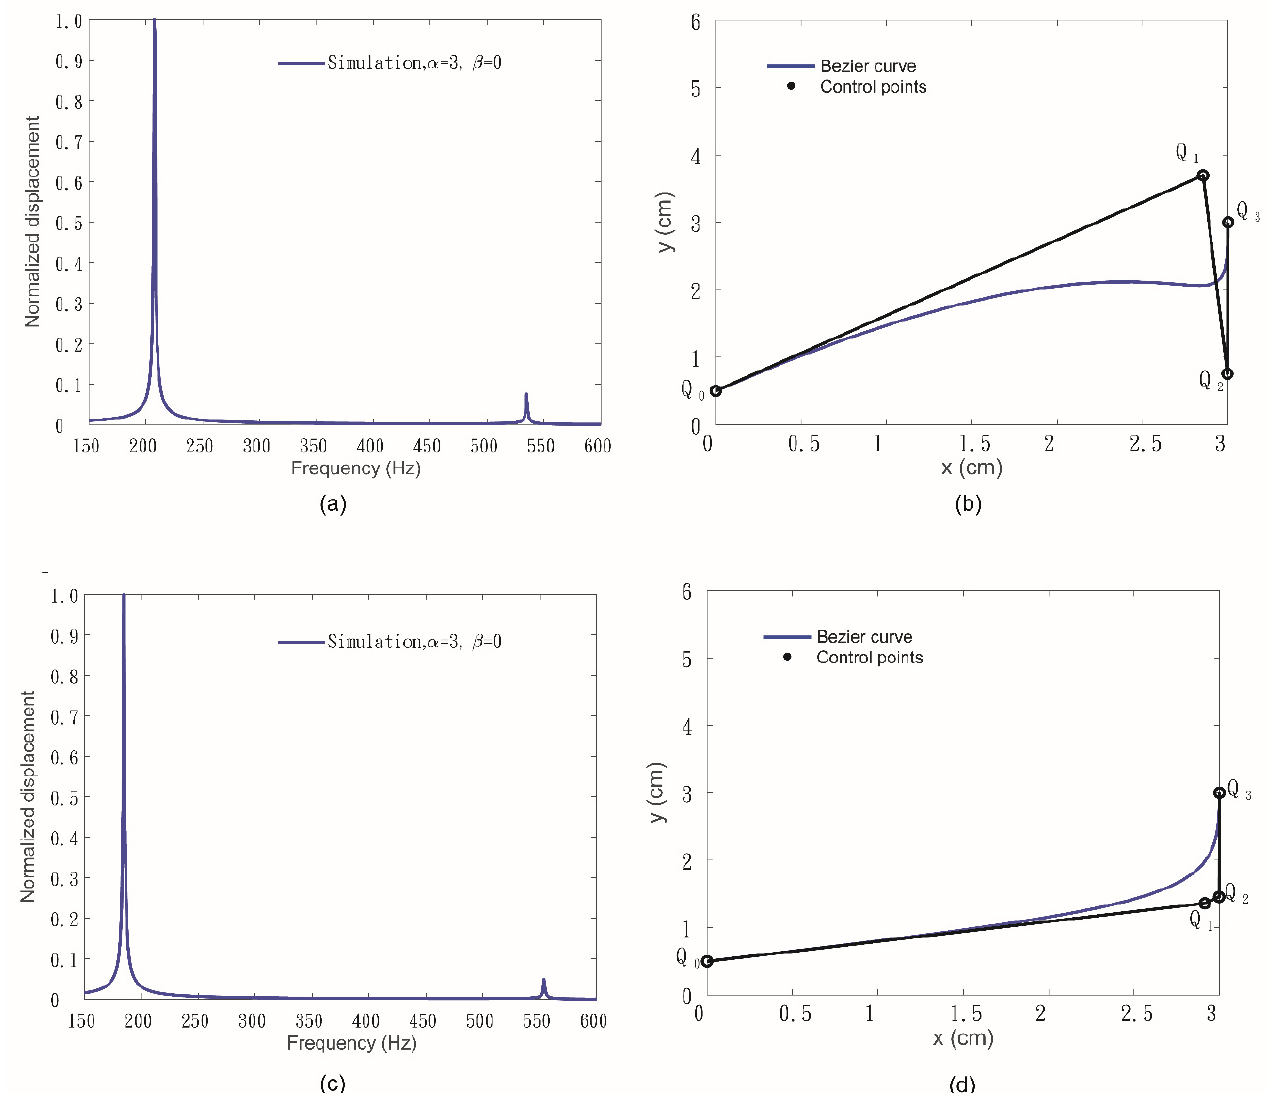
Figure 8. Normalized frequency response functions for S = 2.6 ( a ) and S = 3.0 ( c ); and the profiles of an optimized Bézier plate for S = 2.6 ( b ) and S = 3.0 ( d ).